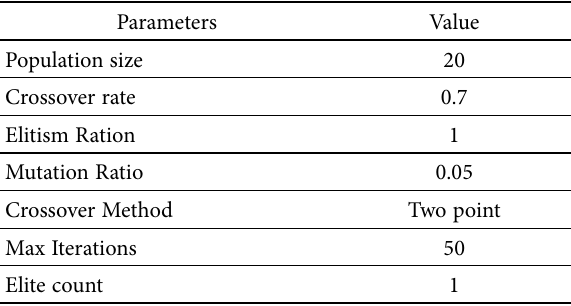
Table 8. GA’s Parameters